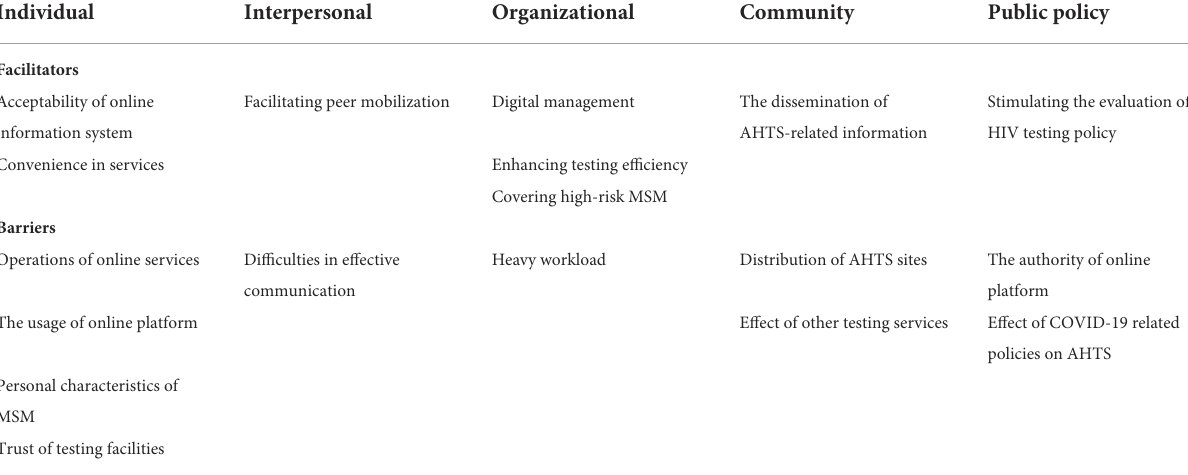
TABLE 1 Multilevel influencing factors of providing AHTS in